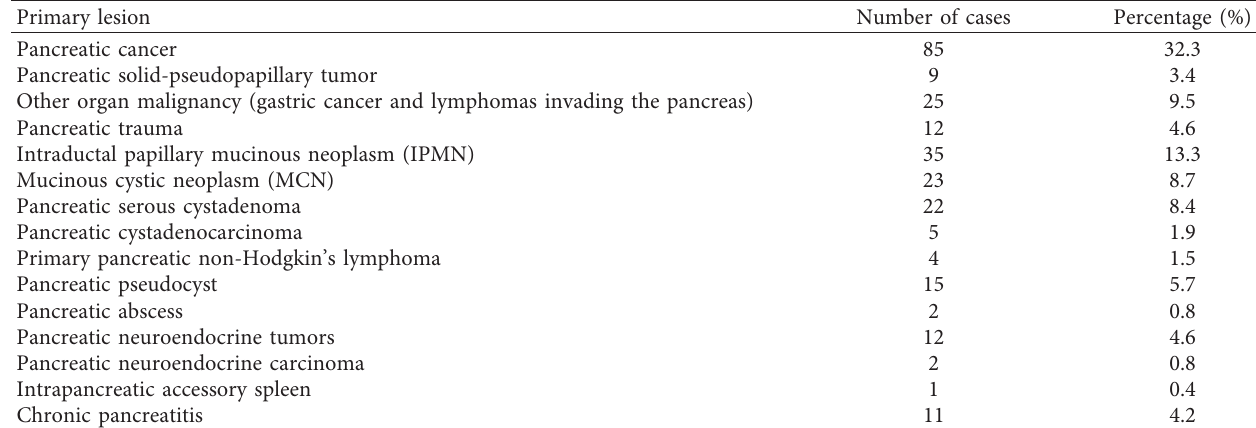
Table 1: Primary lesions in 263 patients undergoing